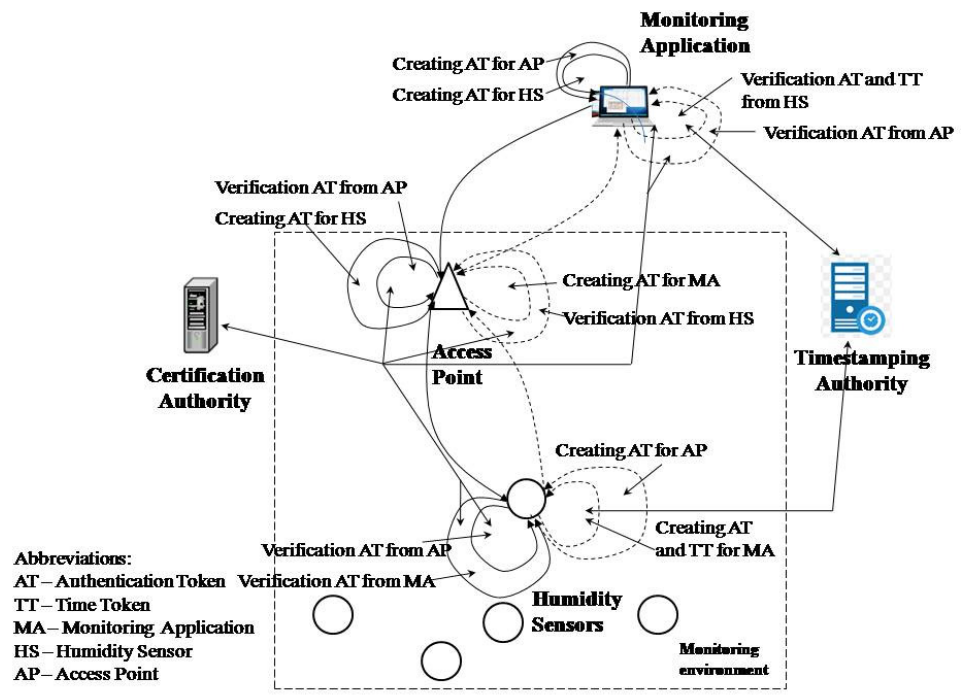
Figure 1. Model for trust in a WSN for humidity and moisture monitoring.